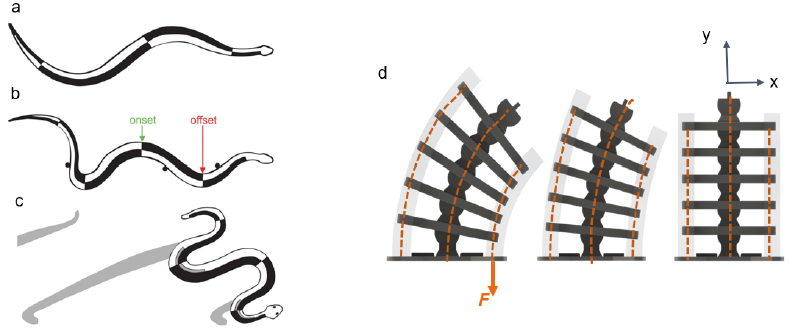
Figure 2. ( a – c ) Undulations in snakes [22]: the black-shaded areas are the muscle timing relative to bending in ( a ) swimming and ( b ) lateral undulation of a water snake and ( c ) sidewinding in a rattlesnake. The outside gray areas are past regions of static contact with the ground; note the onset and offset bending points. ( d ) Bends in our snake-inspired system: the transparent sections are the hyperelastic (soft) material connecting the ribs and providing antagonistic variable stiffness and energy storage–release. Kevlar fibers in the soft material and centerline provide actuation and prevent socket shifting,